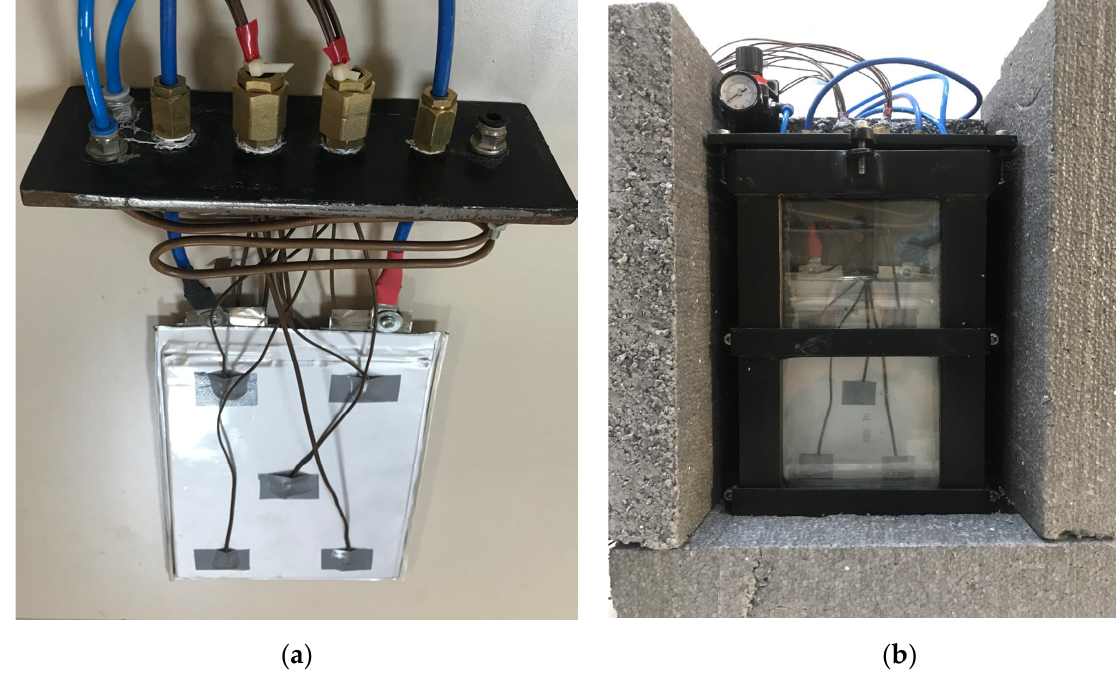
Figure 1. ( a ) The positions of surface thermocouples and cover connections, ( b ) The photo of test box.